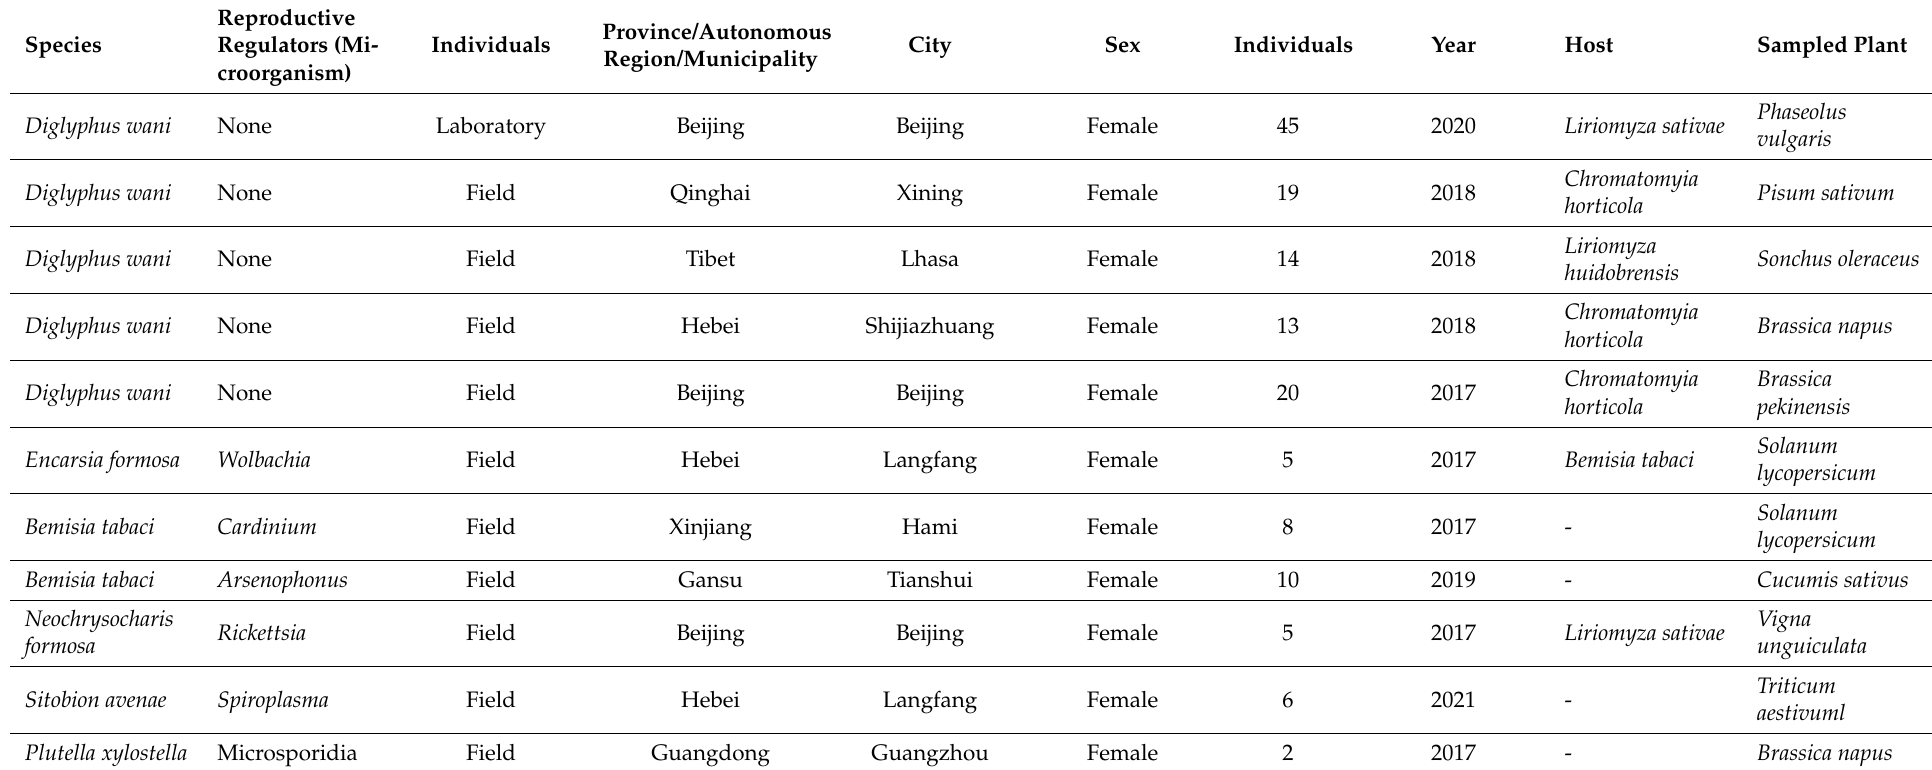
Table 1. Thelytokous Diglyphus wani and species infected with microorganisms collected in this